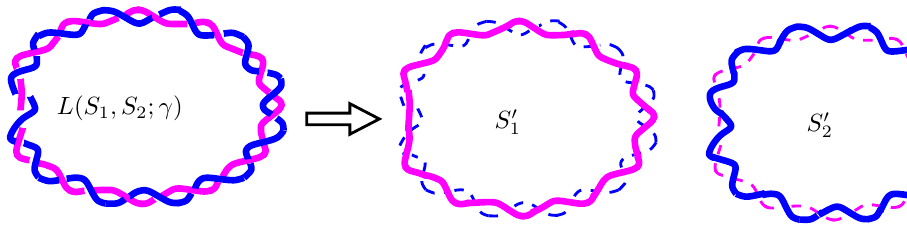
Fig. 3. The semi-conservative scheme is topologically interpreted as splitting the DNA-link.